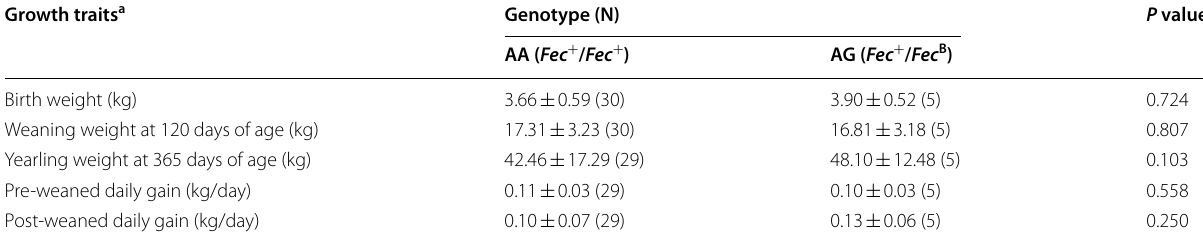
N number of animal a Corrected